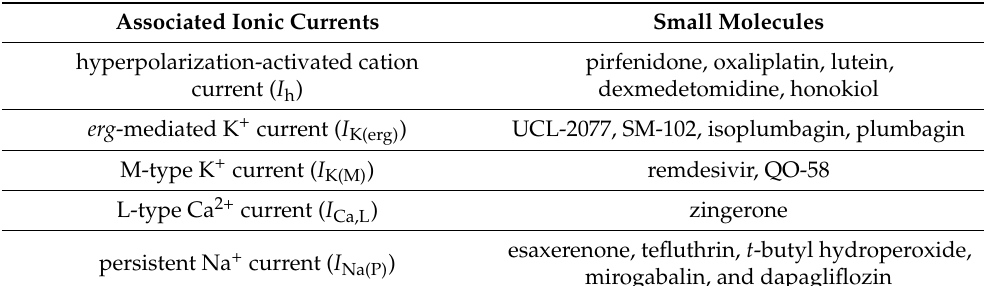
Table 1. Summary in the perturbations of the known small-molecule modulators on voltage- dependent hysteresis (Hys (V) ) behavior occurring in different types of ionic currents present in excitable cells (e.g., pituitary GH 3